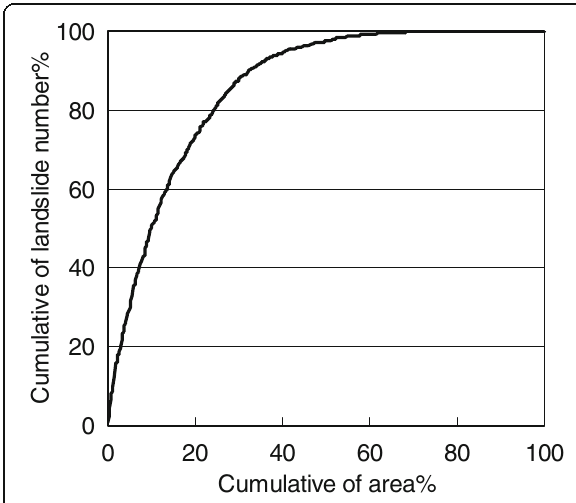
Fig. 15 The area under the curve representing the success ratio of the landslide hazard assessment. Area % means the percentage of area to the study area for each factor class. Landslide number % means the percentage of landslide number in a factor class to the total landslide number